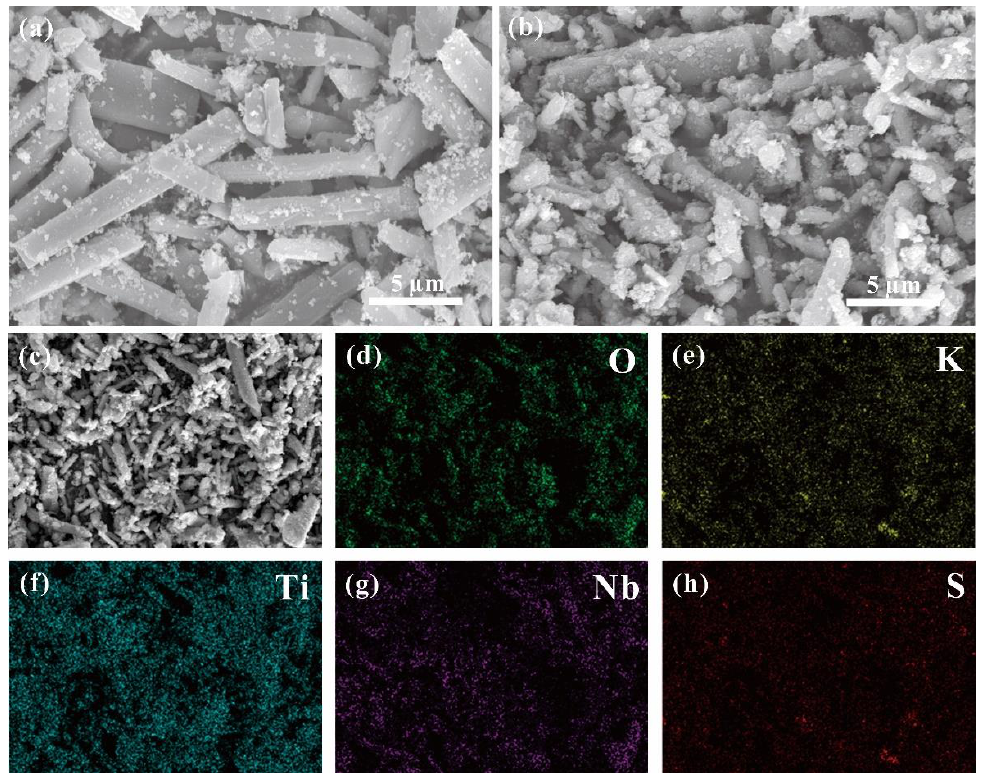
Figure 2. SEM images of ( a ) K 3 Ti 5 NbO 14 and ( b ) S-doped K 3 Ti 5 NbO 14 @TiO 2 -3 (STNT3). ( c – h ) SEM-EDS Figure2. SEMimagesof( a )K 3 Ti 5 NbO 14 and( b )S-dopedK 3 Ti 5 NbO 14 @TiO 2 -3(STNT3). ( c – h )SEM-EDS mappings of STNT3 with the distribution of O, K, Ti, Nb, and S elements. mappings of STNT3 with the distribution of O, K, Ti, Nb, and S elements. Nanomaterials 2019 , 9 , x FOR PEER REVIEW